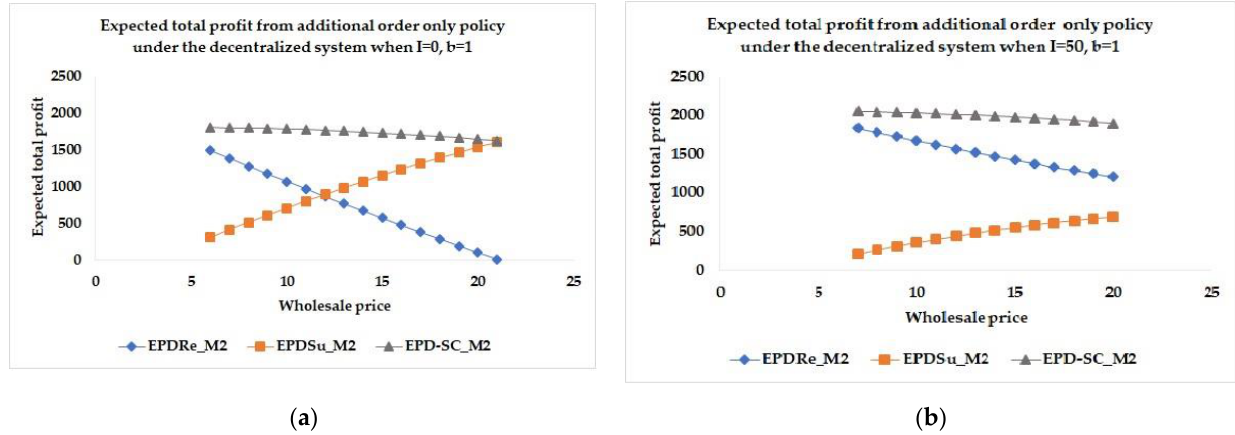
Figure 7. The expected total profit of the retailer, the supplier, and the supply chain of additional order only policy under the decentralized system with different values of w , where b = 1 and ( a ) I 0 = 0; ( b ) I 0 = 50.